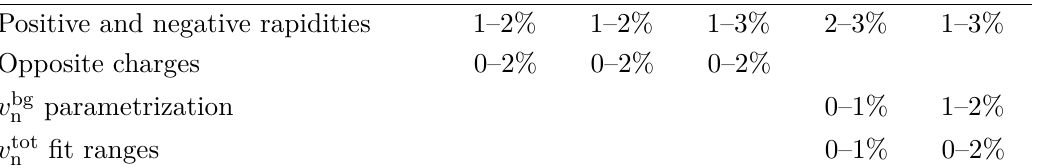
, and Λ + Λ . Uncer- S